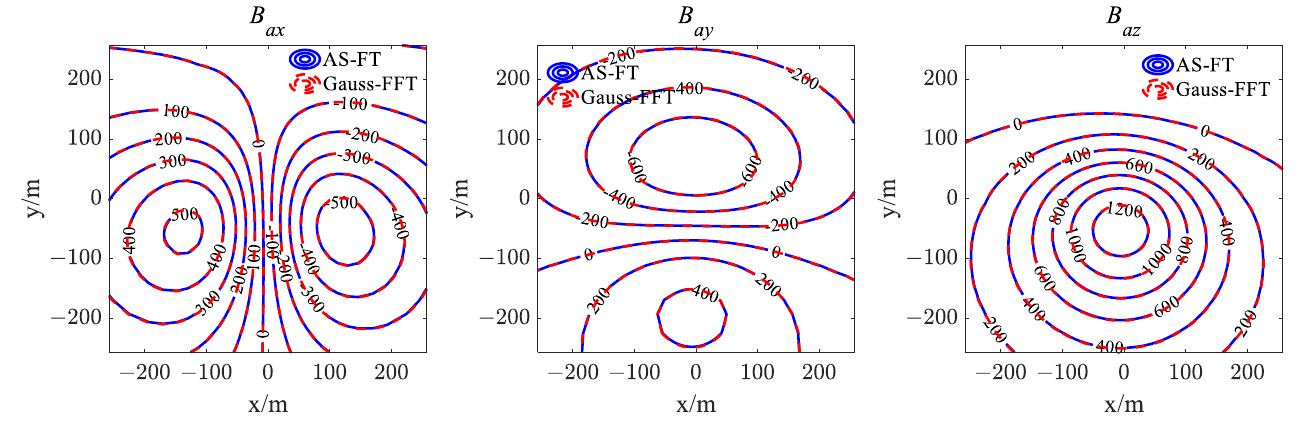
Figure 16. Schematic diagram of horizontal non-uniform sectioning. ( a ) Spatial domain sample, ( b ) Wavenumber domain sample.